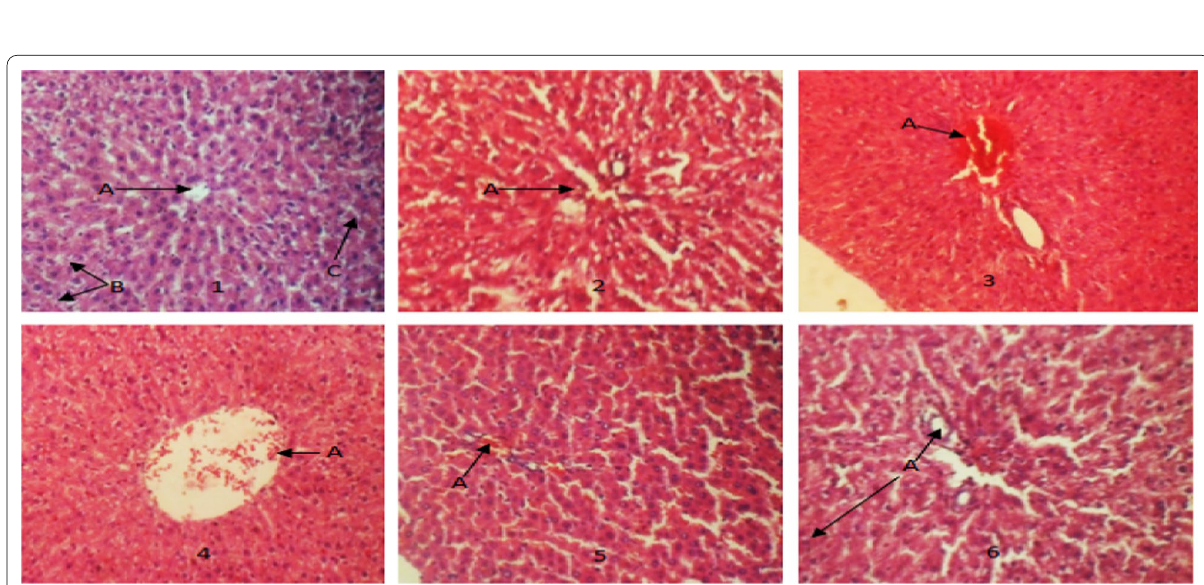
Fig. 12 Effect of n-hexane leaf extract of Ipomoea batatas L . on the liver. (1) The control Rat liver composed of A—central vein, B—hepatocytes and C—sinusoids, (2) Rat liver treated with phenylhydrazine alone showed A—patchy vascular intimal ulceration, (3) rat liver treated with 5 mg/kg of ferrous (iii) hydroxide poly-maltose showed A—moderate vascular congestion, (4) at 125 mg/kg n-hexane extract showed mild vascular congestion (5) at 250 mg/kg n-hexane showed A—mild vascular congestion and (6) at 500 mg/kg n-hexane extract showed A-normal liver architecture (H&E 100) of hepatocytes. They were using haematoxylin–eosin dye with X 40 ×